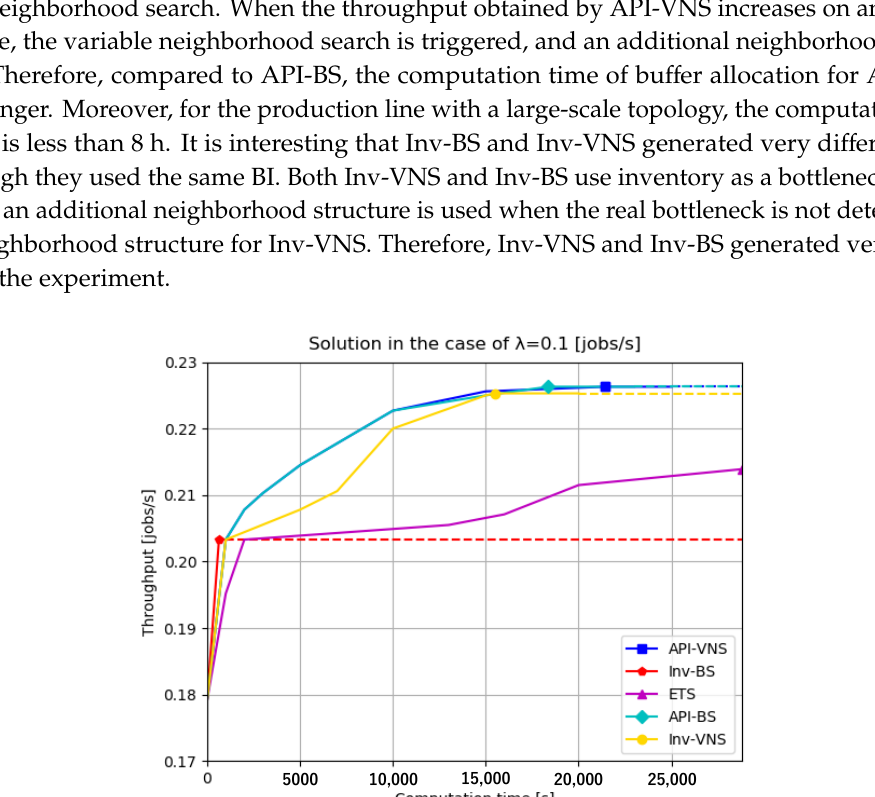
Figure 17. Computation time vs. throughput curves for the five methods in the case of 𝜆 = .2 in experiment 2. Figures 18 and 19 show the scatter plots of the designed buffer size versus the solution throughput for the five methods in the cases of 𝜆 = .1 and 𝜆 = .2 , respectively. API-VNS and API- BS achieved the highest solution throughput with the same designed buffer size, followed by Inv- VNS and ETS. The solution throughput obtained by Inv-BS was the lowest. Both API-VNS and API- BS use the API as the BI to detect the bottleneck of a production line. For large-scale topology, the effectiveness of the API is so high that all real bottlenecks are detected by the initial neighborhood structure. Therefore, API-VNS and API-BS have a similar solution quality in the experiment. Because the effectiveness of the inventory indicator for the large-scale topology is low, it is difficult to detect the real bottleneck and increase the buffer size. Therefore, the solution throughput obtained by Inv- BS is the lowest, which shows the worst solution quality among all comparison methods. ETS adds several buffers in each buffer update and it tests more candidate buffer allocation solutions; therefore, it allocated buffers and increased the throughput very slowly in the experiment.